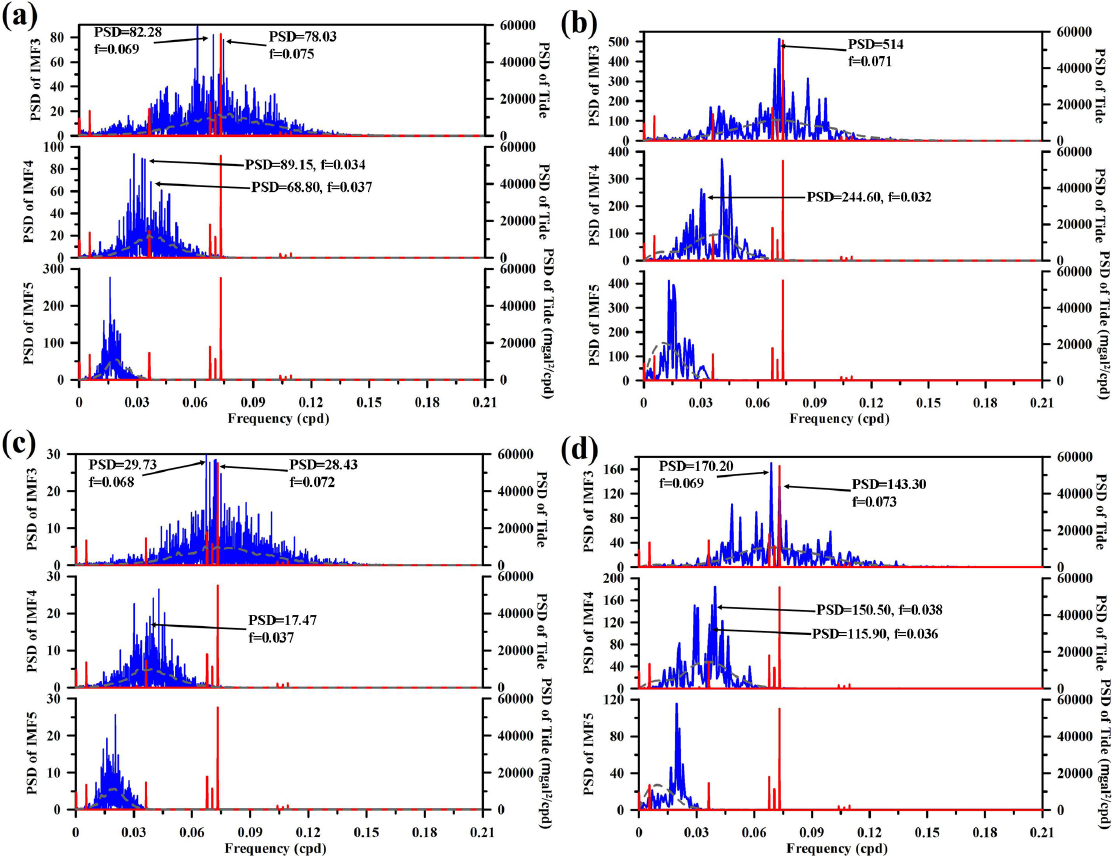
Fig. 5. The Fourier PSDs of IMFs (IMF3 to IMF5 from top to bottom) extracted from (a) non-stacked and (b) stacked earthquake data from the Resenberg declustered catalog, and those from (c) non-stacked and (d) stacked earthquake data from the Gardner and Knopoff declustered catalog. The PSD of theoretical Earth tides calculated at the center of Taiwan are displayed by the red line segments, and the PSDs at a 95% confidence level are depicted by the dashed lines.